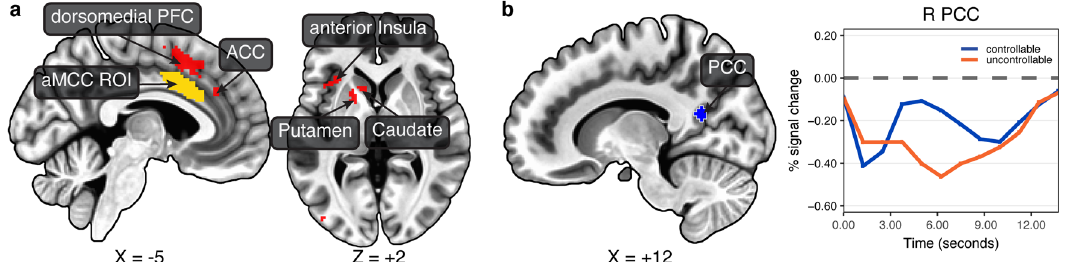
Fig. 7 Voxelwise contrast of uncontrolled vs. controlled participants. Maps were thresholded at 0.001 at the voxel level and 0.05 at the cluster level (13 voxels). a The anterior midcingulate cortex region of interest (yellow) is shown so that its location can be compared to the voxelwise activation clusters that exhibited greater responses in uncontrollable participants. b The posterior cingulate was the only cluster that showed a greater response in controllable participants. ACC anterior cingulate cortex, aMCC anterior midcingulate cortex, PCC posterior cingulate cortex, PFC prefrontal cortex.